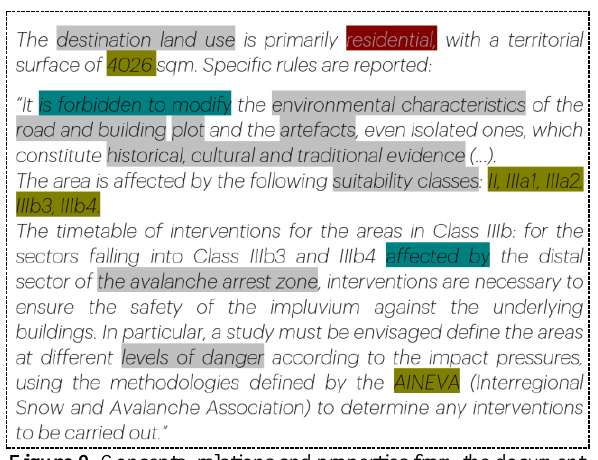
Figure 9. Concepts, relations and properties from the document “Schede e Tabelle di Zona.